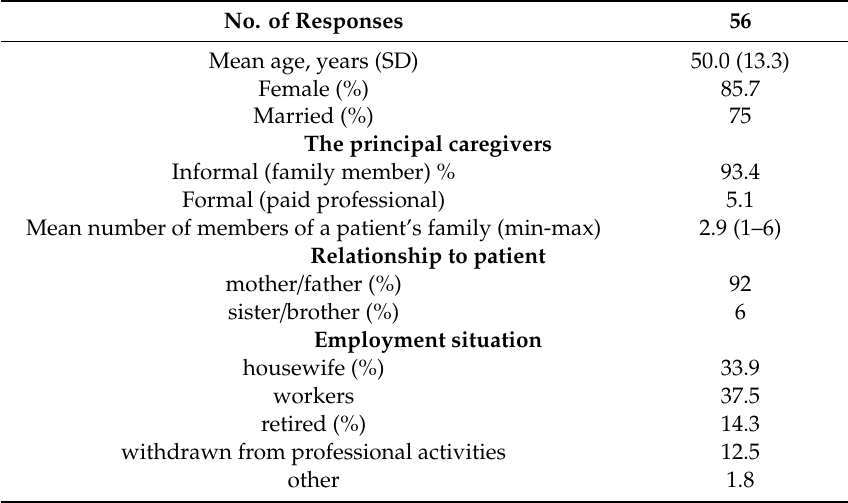
Table 2. Characteristics of the study caregivers.